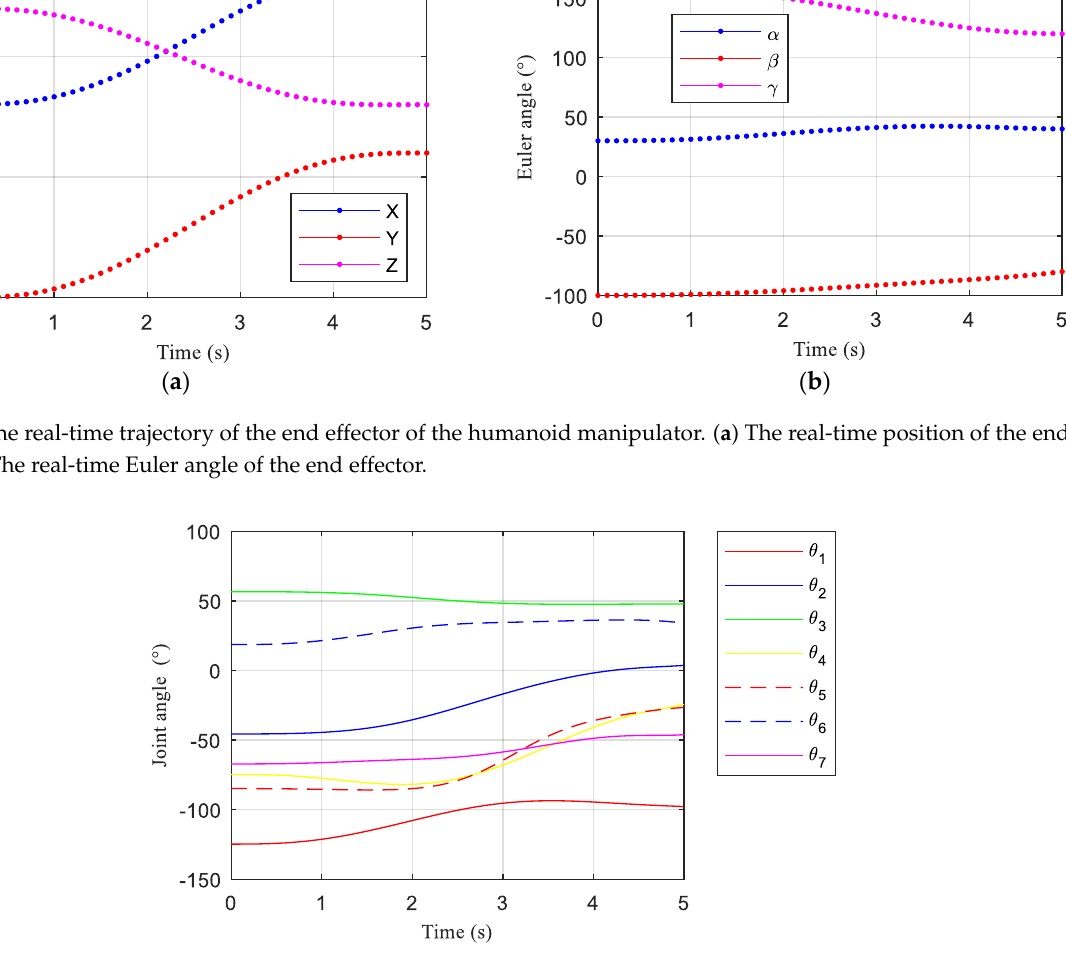
Figure A5. The real-time angles of the joints of the humanoid manipulator during the movement.